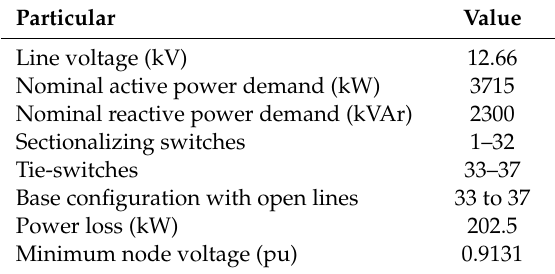
Table 1. Brief data of the test